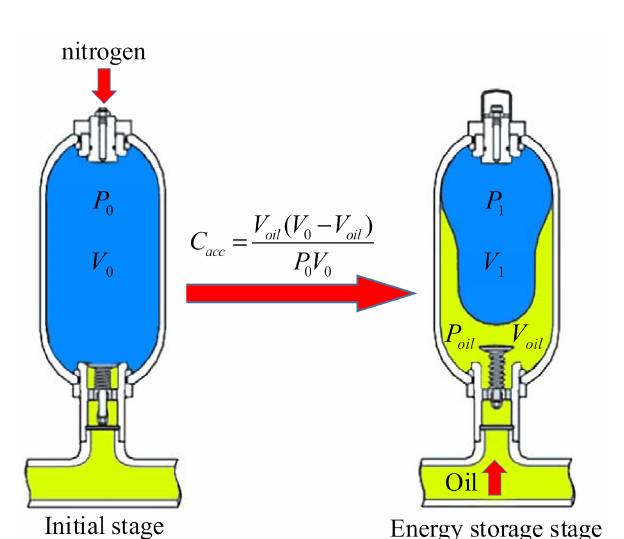
Figure 3. Charging process of the